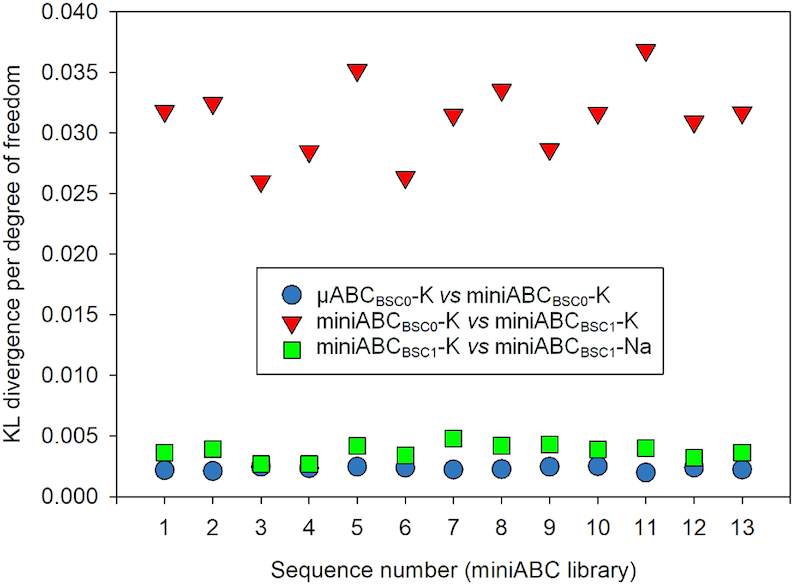
Symmetric Kullback–Leibler divergence per degree of freedom between Gaussian distributions, which is a combined measure of differences in values of first and second moments, for each of the thirteen oligomers in the miniABC training library, but for cgDNA model parameter sets fitted to different MD simulation protocols (see Materials and Methods and Supplementary Methods).